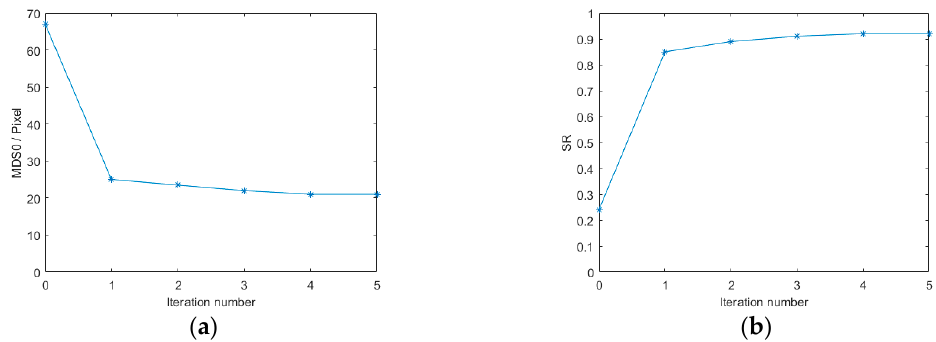
Figure 9. 0 MDS curve; ( b ) Sterhl ratio (SR) curve.